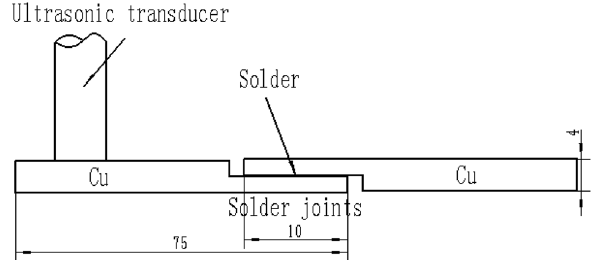
Figure 1. Geometry of the dimension of solder joints samples and application USW to samples (Unit: